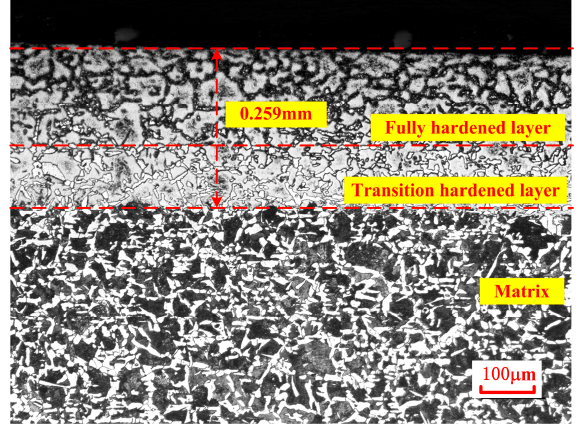
Figure 11. Microstructure after grind-hardening experiment by metallurgical microscopy.